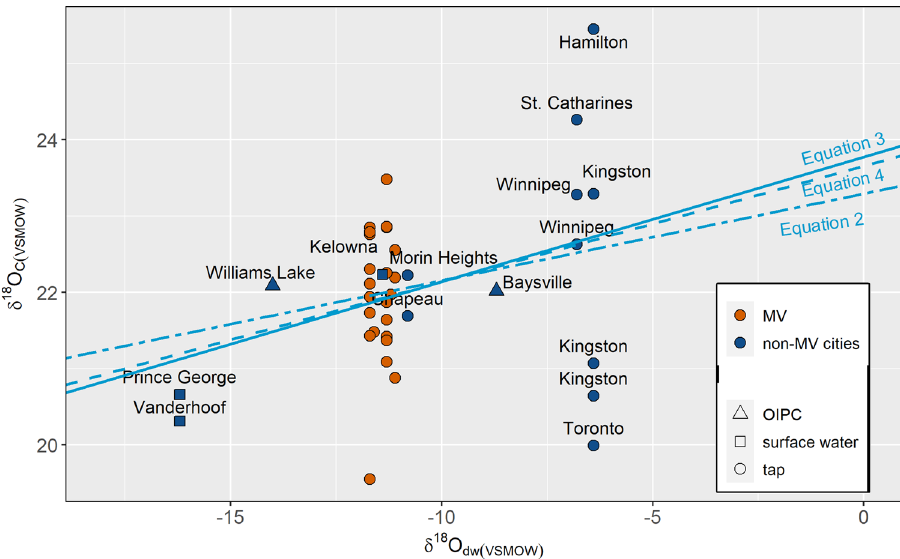
Figure 7. The relationships between δ 18 O c(VSMOW) and δ 18 O dw values are shown for individuals who had resided in Canada during tissue formation (n = 41). Colours indicate the MV or non-MV residence, and shapes indicate the type of drinking water sampled for its δ 18 O dw value. The different line types show the regression line between δ 18 O c and δ 18 O tap values for Eq. (2): δ 18 O c(VSMOW) = 0.11 (± 0.09) × δ 18 O tap(VSMOW) + 23.29 (± 0.98); [df = 32; R 2 = 0.01], δ 18 O dw values including both tap and surface water values for Eq. (3): δ 18 O c(VSMOW) = 0.16 (± 0.08) × δ 18 O dw_1(VSMOW) + 23.77 (± 0.82); [df = 35; R 2 = 0.09] and δ 18 O dw values for all samples for Eq. (4):